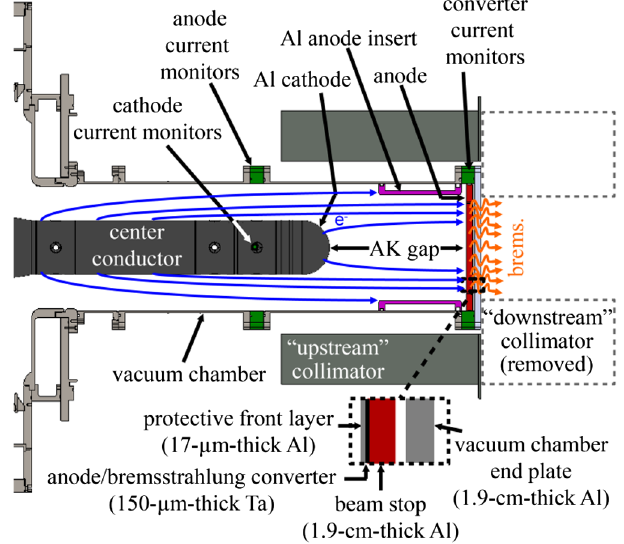
FIG. 1. Diode region geometry and electrical diagnostics for this experiment. The MITL feeds the diode from the left. An additional “ downstream ” collimator (shown as dashed lines) was not fielded during this experiment but served as a constraint on the useful electron beam